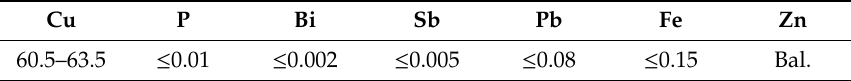
Table 2. Chemical composition of H62 brass (mass fraction / %).